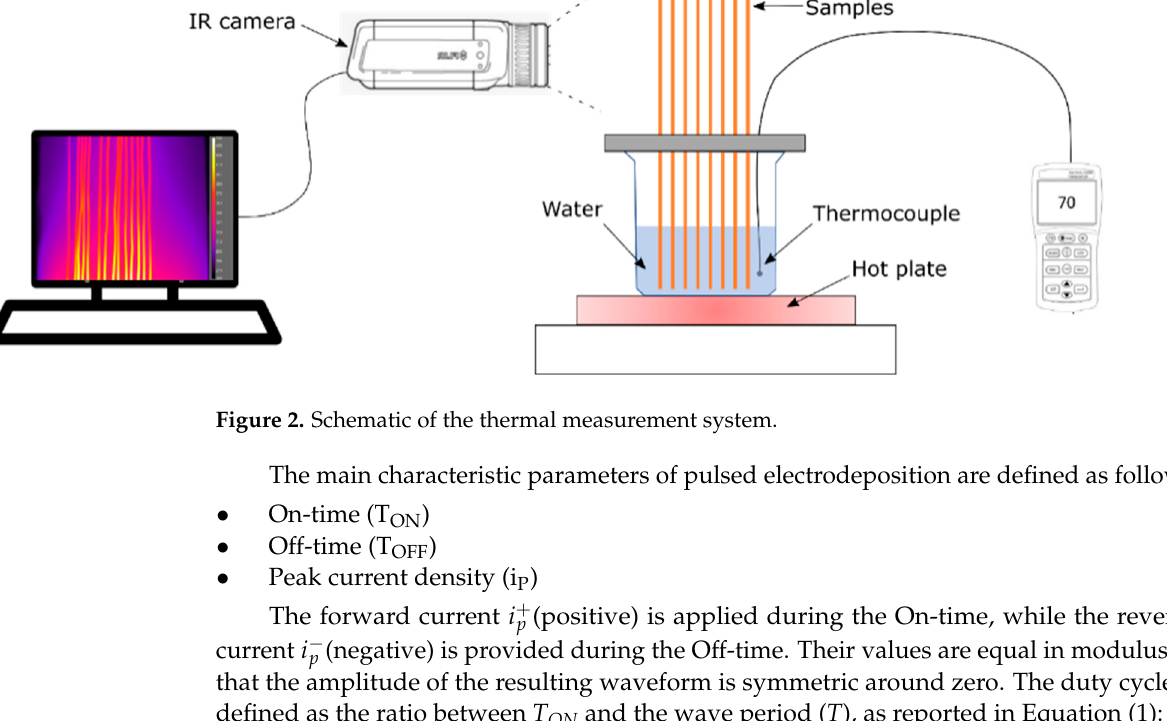
Figure 1. ( a ) Square wave for the AC galvanic process; ( b ) schematic of the electroplating process. The main characteristic parameters of pulsed electrodeposition are defined as fol- lows: